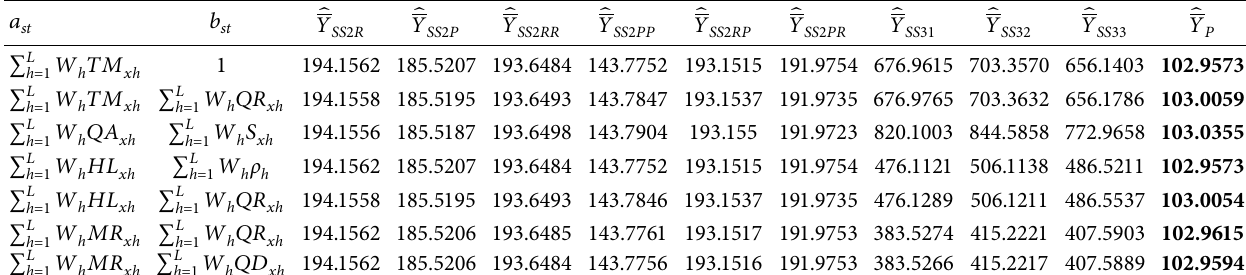
Table 5: MSEs of 􏽢 Y